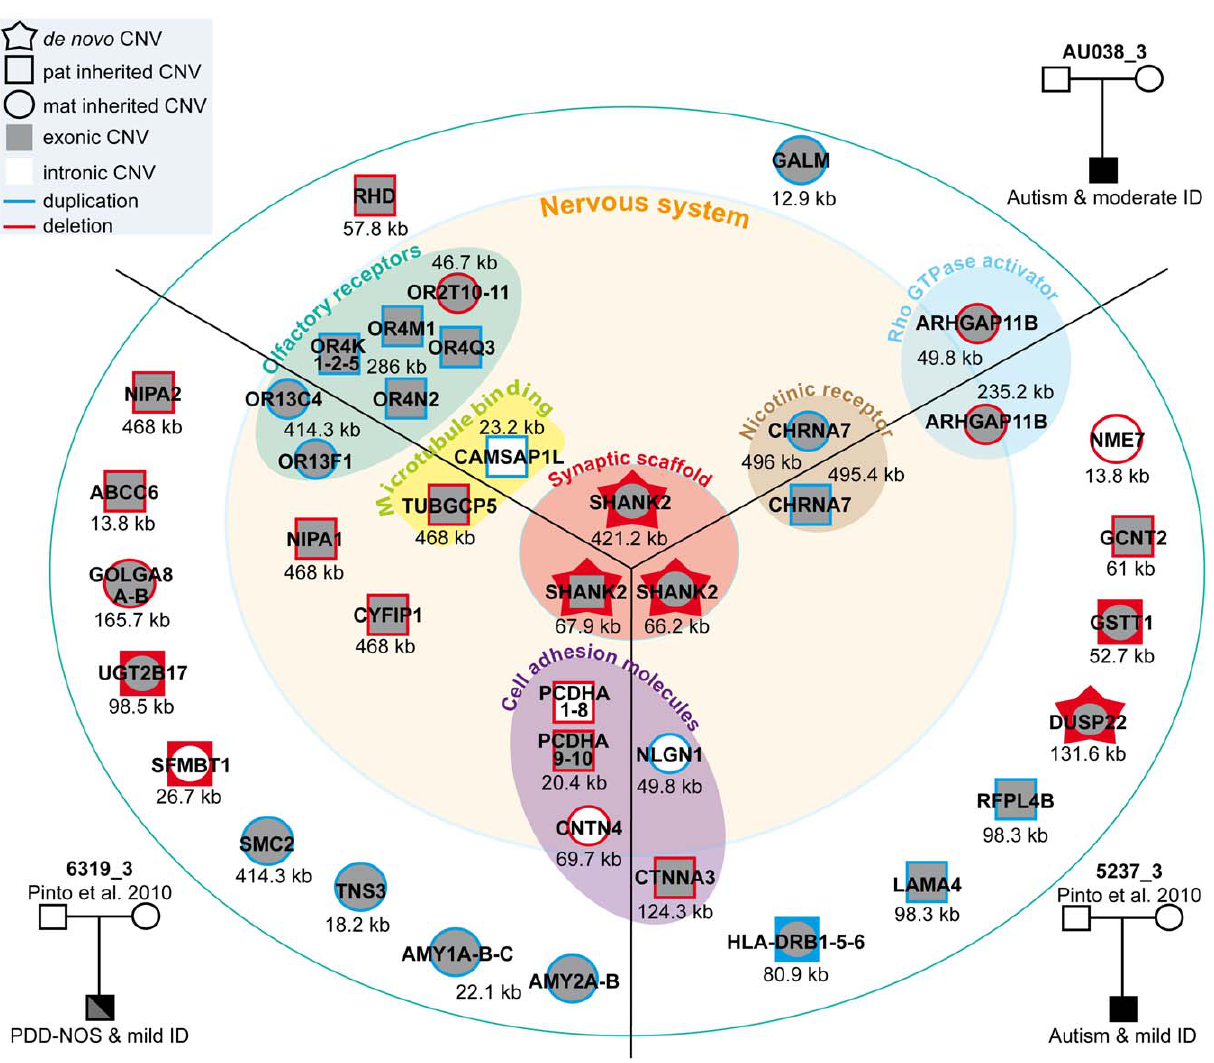
Figure 5. Characterization of CNVs in three patients carrying a denovo deletion of SHANK2 . Paternally or maternally inherited CNVs are indicated by squares and circles, respectively. De novo CNVs are indicated by stars. Deletions and duplications are indicated in red and blue, respectively. CNVs hitting exons or only introns are filled with grey and white, respectively. Squares and circles within star represent de novo CNV of paternal or maternal origin; circles within squares represent CNV inherited by father or mother. ABCC6, ATP-binding cassette, sub-family C, member 6 pseudogene 2; ADAM, ADAM metallopeptidase; AMY1, amylase (salivary); AMY2A, amylase (pancreatic); ARHGAP11B, Rho GTPase activating protein 11B; CAMSAP1L1, calmodulin regulated spectrin-associated protein 1-like 1; CHRNA7, cholinergic receptor, nicotinic, alpha 7; CNTN4, contactin 4; CTNNA3, catenin (cadherin-associated protein), alpha 3; CYFIP1, cytoplasmic FMR1 interacting protein 1; DUSP22, dual specificity phosphatase 22; GALM, galactose mutarotase; GCNT2, glucosaminyl (N-acetyl) transferase 2; GOLGA, golgi autoantigen, golgin subfamily a; GSTT1, glutathione S- transferase theta 1; HLA-DRB, major histocompatibility complex, class II, DR beta; LAMA4, laminin, alpha 4; NIPA, non imprinted in Prader-Willi/ Angelman syndrome; NLGN1, neuroligin 1; NME7, non-metastatic cells 7; OR, olfactory receptor; PCDHA, protocadherin alpha; RFPL4B, ret finger protein-like 4B; RHD, Rh blood group, D antigen; SFMBT1, Scm-like with four mbt domains 1; SHANK2, SH3 and multiple ankyrin repeat domains 2; SMC2, structural maintenance of chromosomes 2; TNS3, tensin 3; TUBGCP5, tubulin, gamma complex associated protein 5; UGT2B17, UDP glucuronosyltransferase 2 family, polypeptide B17.